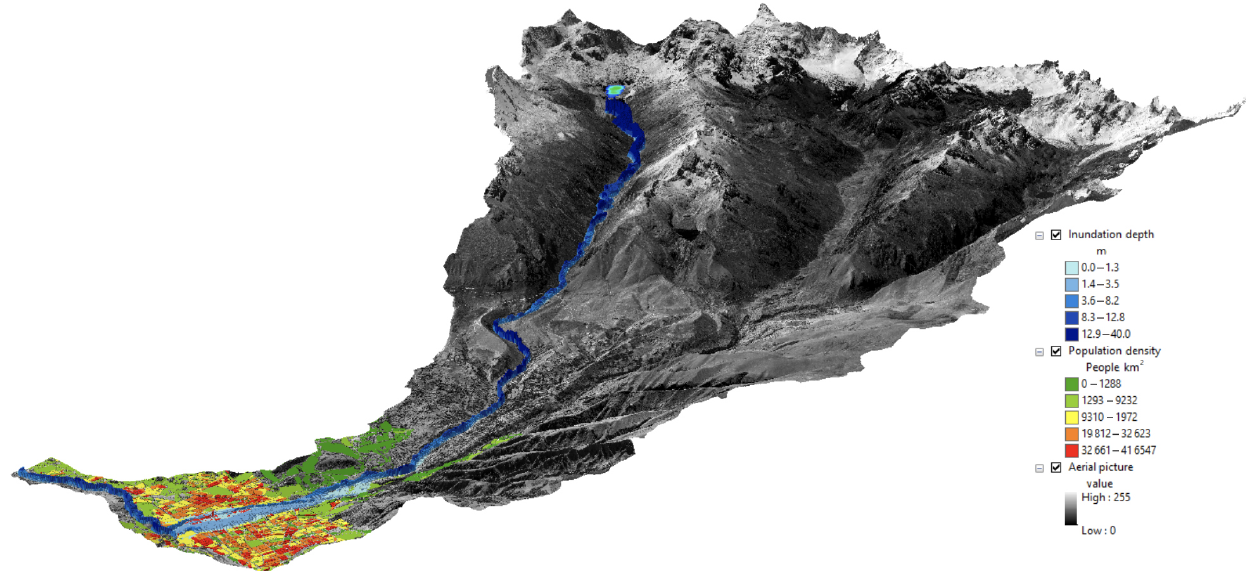
Figure 2. Huaraz, Peru, at the bottom of the Cojup River. Lake Palcacocha, a potential source of a GLOF, is located at the head of the